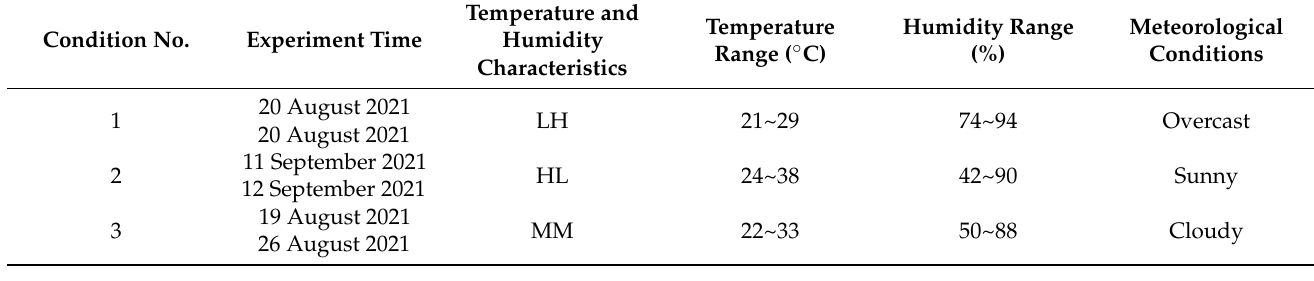
Table 5. Outdoor weather conditions classification table.